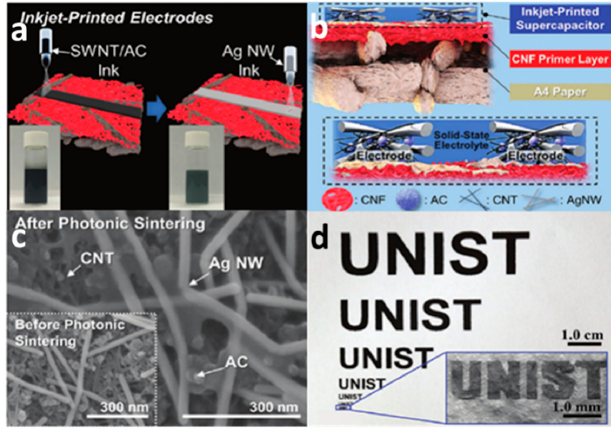
Figure 5. Schematic diagram of inkjet printing a supercapacitor with active carbon composite ink; ( a ) Prepare supercapacitors by inkjet printing AC/SWNT inks and Ag inks, respectively; ( b ) Inkjet printing AC/SWNT electrode structure; ( c ) Scanning electron microscope ( SEM) images of inkjet printed AC/SWNT electrode; ( d ) Inkjet printed electrode with the shape of UNIST on A4 paper. Reproduced from [55], with permission from Royal Society of Chemistry, 2016.